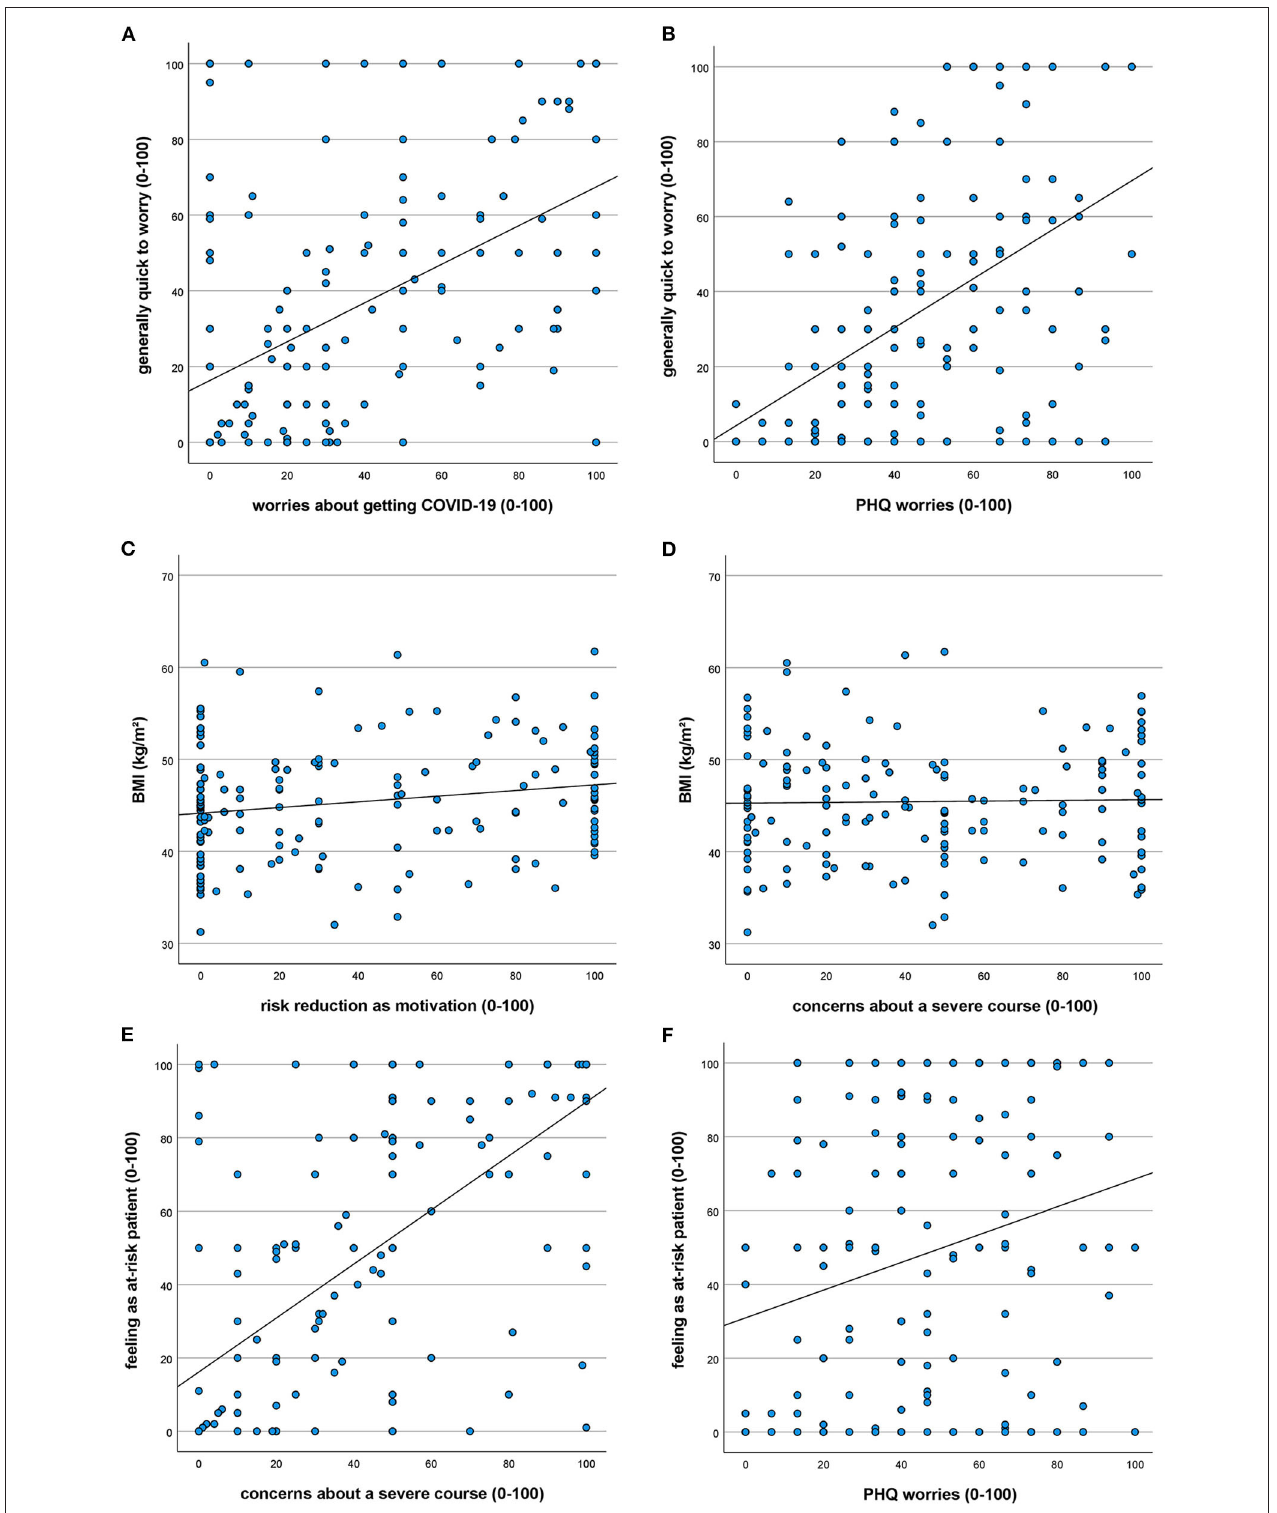
FIGURE 1 | Correlations regarding COVID-19-related concerns. (A–F) Data are displayed as scatterplots with fit line.